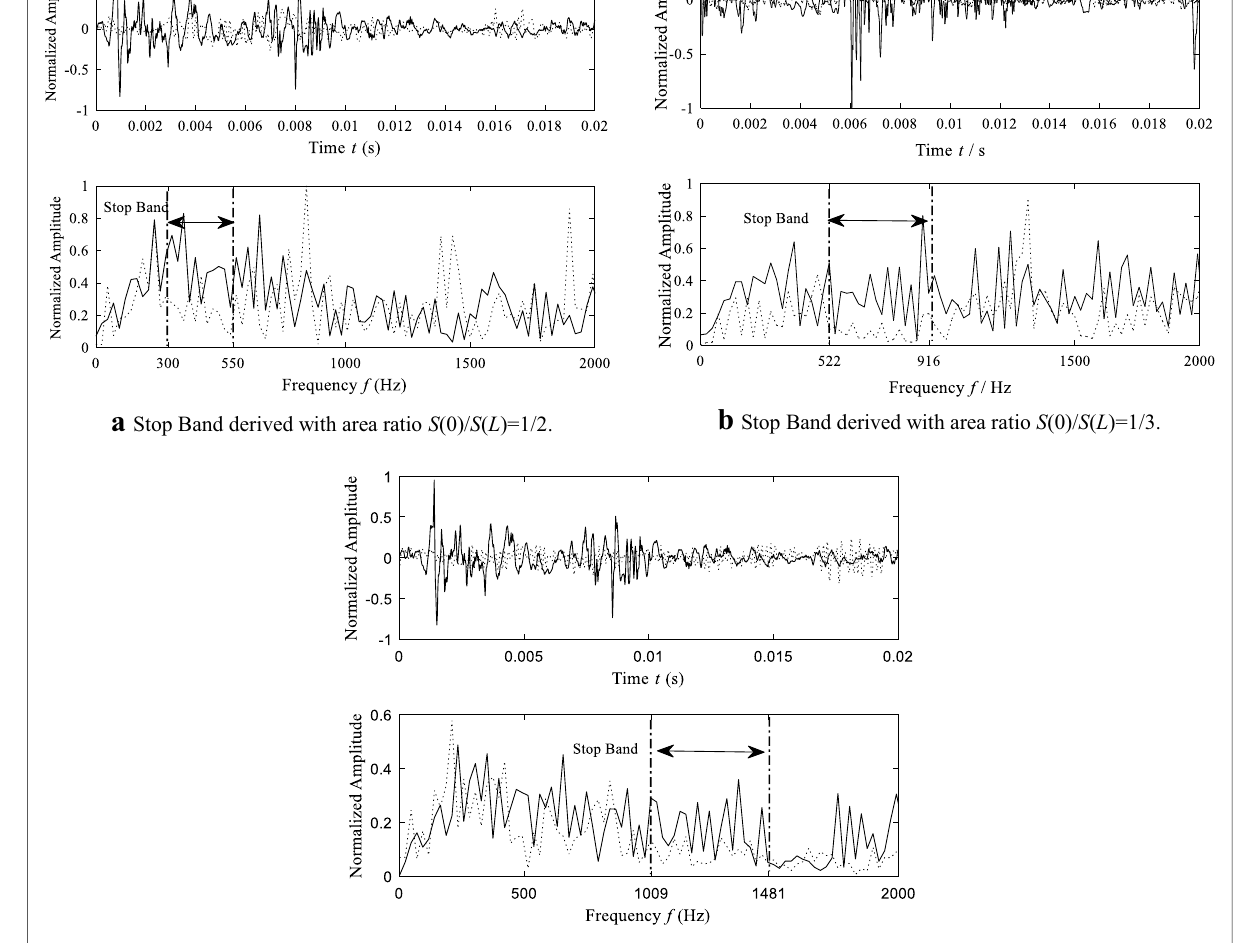
Figure 11 Experimental Stop Band derived at different area